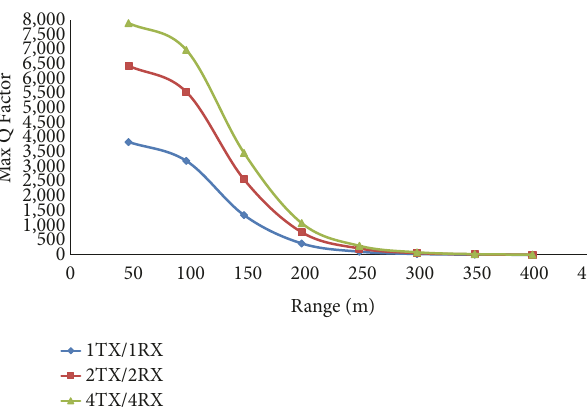
Figure 9: Max Q factor and range (m) at 𝜆 =1550nm and attenuation=190.9 db/km (heavy